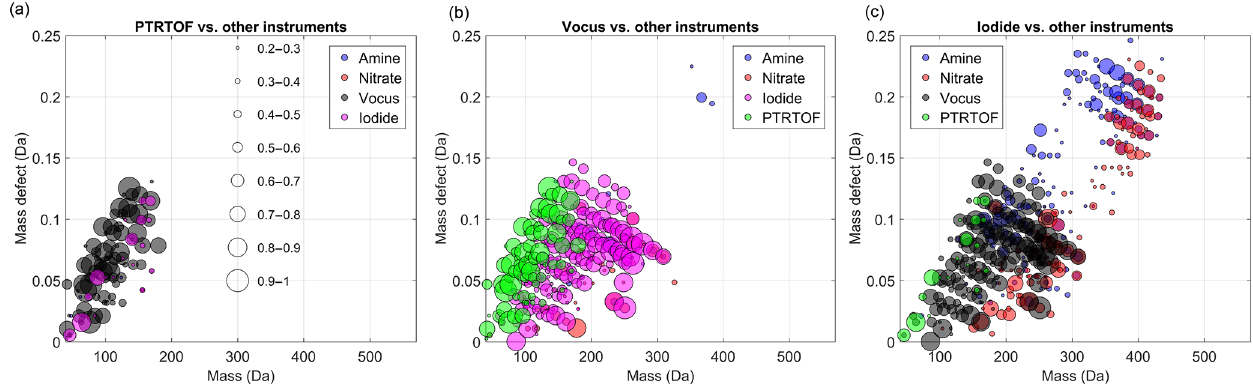
Figure 2. Mass-defect plots showing the compounds for which a time series correlation ( R 2 >0.2) was observed by the medium-pressure chemical ionization mass spectrometers, (a) PTR-TOF, (b) vocus and (c) iodide. Each circle represents a distinct molecular composition and the marker area represents the correlation ( R 2 , legend shown in a ) of the time series of that molecule between two different CIMS instruments. The color of each marker depicts the instrument against which the correlation is